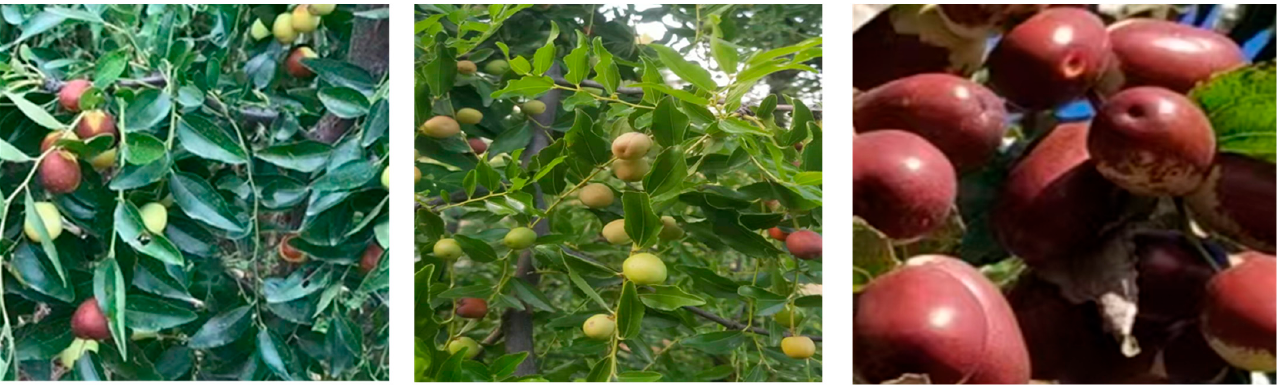
Figure 2. Z. jujuba trees with ripe fruits.